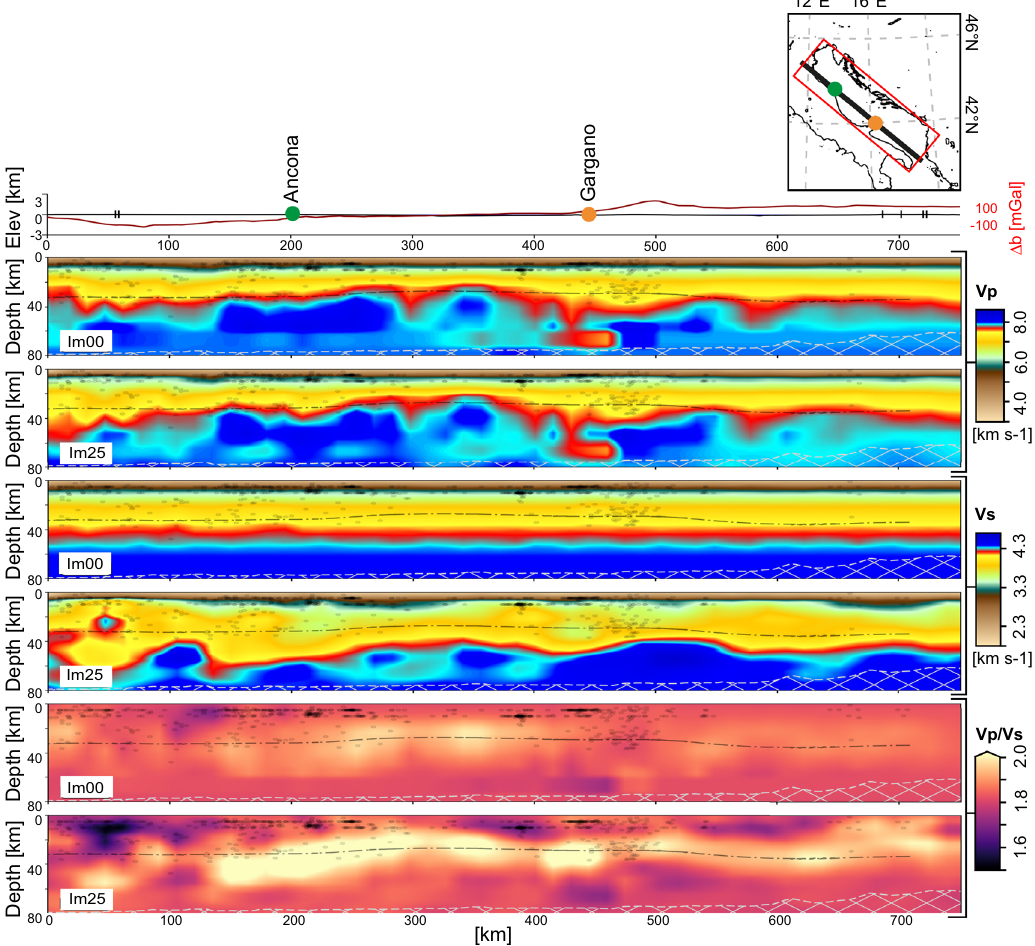
Fig. 5 Detailed vertical cross-section through the Adriatic Sea for Im00 and Im25 . The fi gure shows surface topography and Bouguer anomalies (top), and V p , V s , and the V p / V s ratio for models Im00 and Im25 . Dotted black lines in each section represent the Moho 29 . White dashed areas are not well- resolved in Im25 model. Black dots represent relocated seismicity from the Italian Bulletin of INGV 85